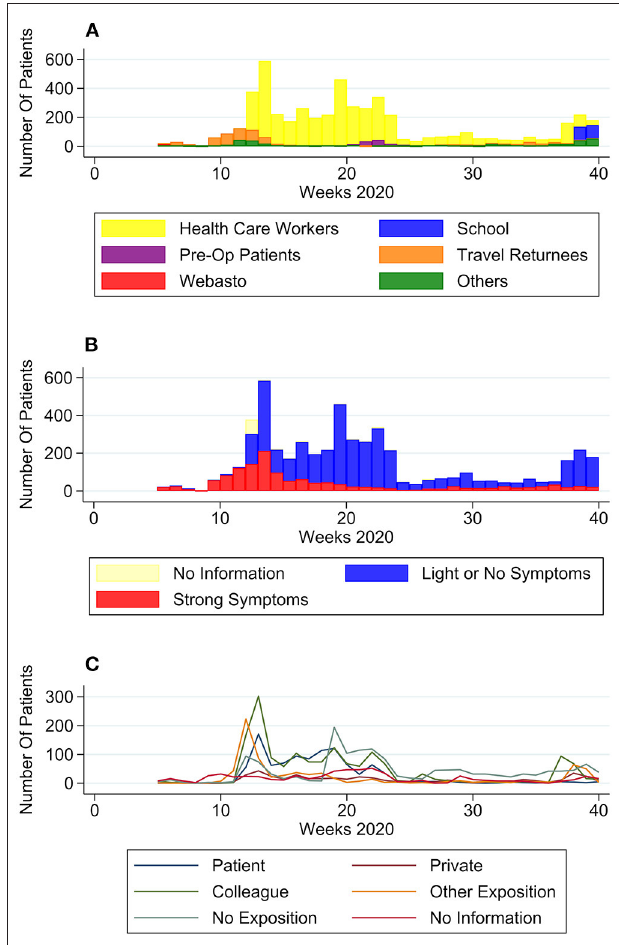
FIGURE 2 | Self-reported patient characteristics over time. (A) Number of patients per group over time, (B) number of patients with no to light symptoms or strong symptoms over time, and (C) number of patients per type of exposition to COVID-19 positive